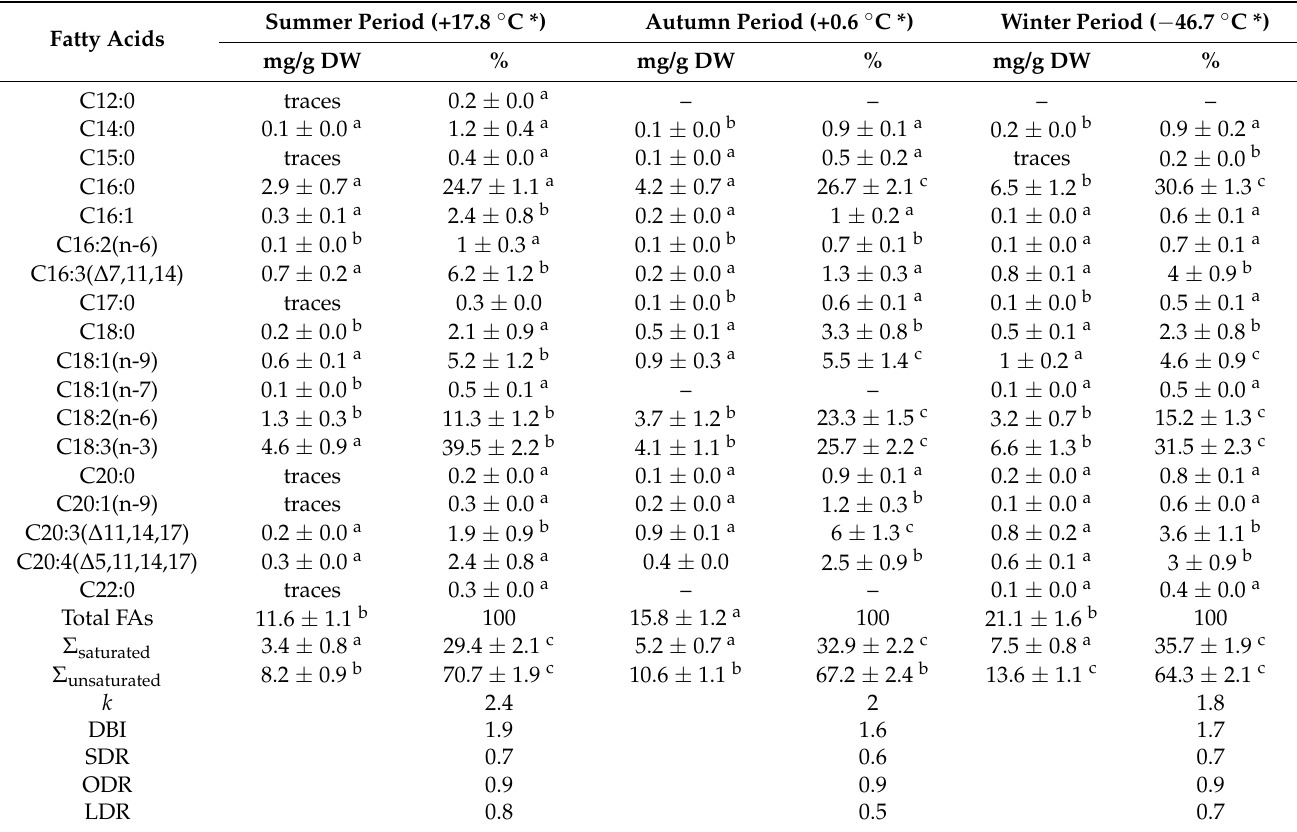
Table 1. Seasonal changes in the FA composition of lipids in shoots of Equisetum variegatum growing at the Pole of Cold. Fatty